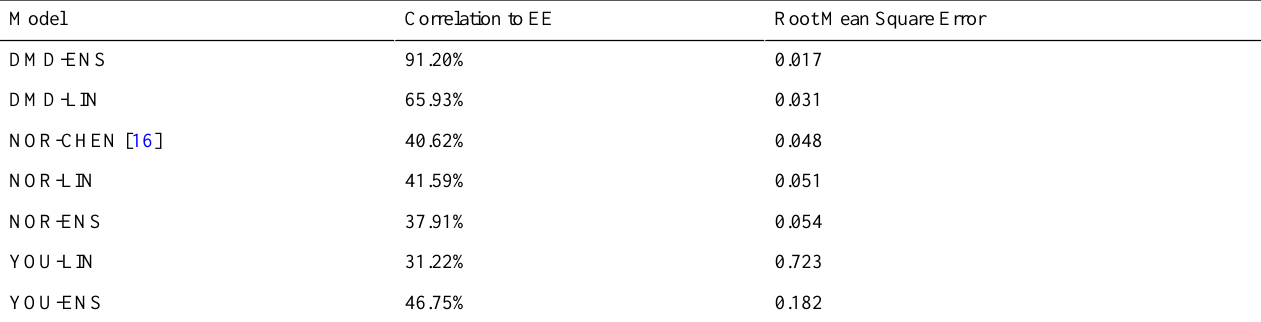
Table 3. Performance comparison of DMD-ENS model with models for normal